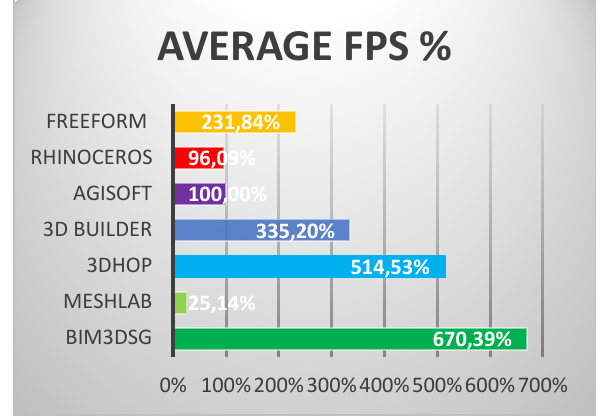
Figure 10: Loading times in percent, setting Agisoft as 100%; lower is better